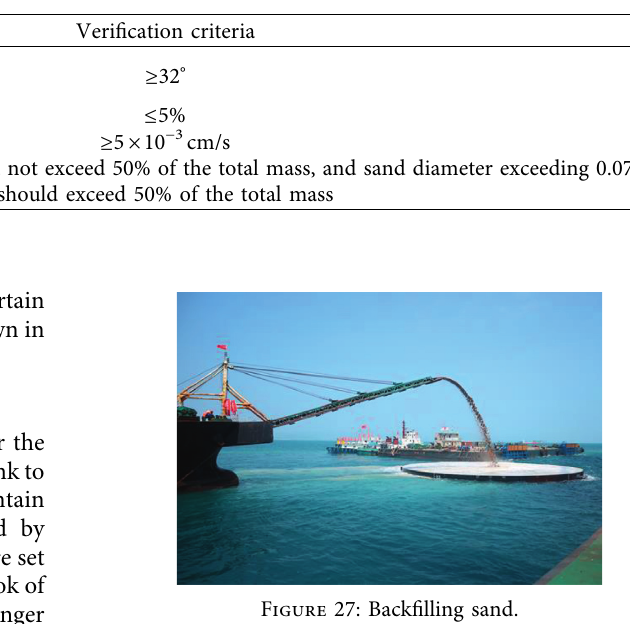
Table 10: Sand verification criteria.